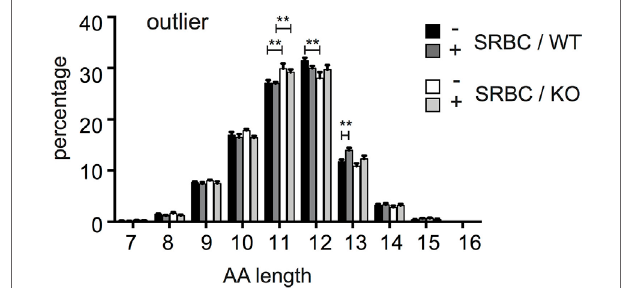
FigUre 4 | TCR β outliers of CD154-deficient mice have shorter complementary determining region 3 (CDR3) regions. Relative length distribution of CDR3 regions of the high-frequent TCR β outliers as described in Figures 3c,D were compared between wild-type and CD154-deficient mice before and after immunization. Mean ± SEM is shown, and bars above columns indicate significant differences between groups multiple t -tests, one per row corrected for multiple comparisons with the Holms Sidak method; ** p ≤